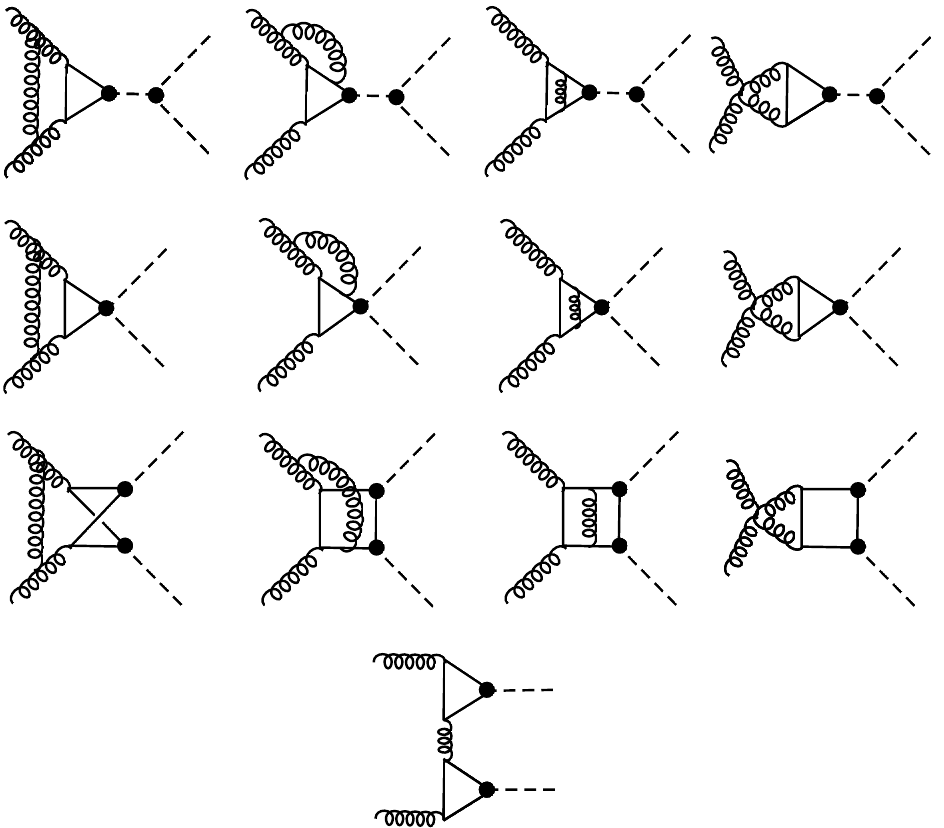
Figure 2. Higgs-pair production in gluon fusion at NLO: examples for virtual two-loop diagrams at order g 4 s